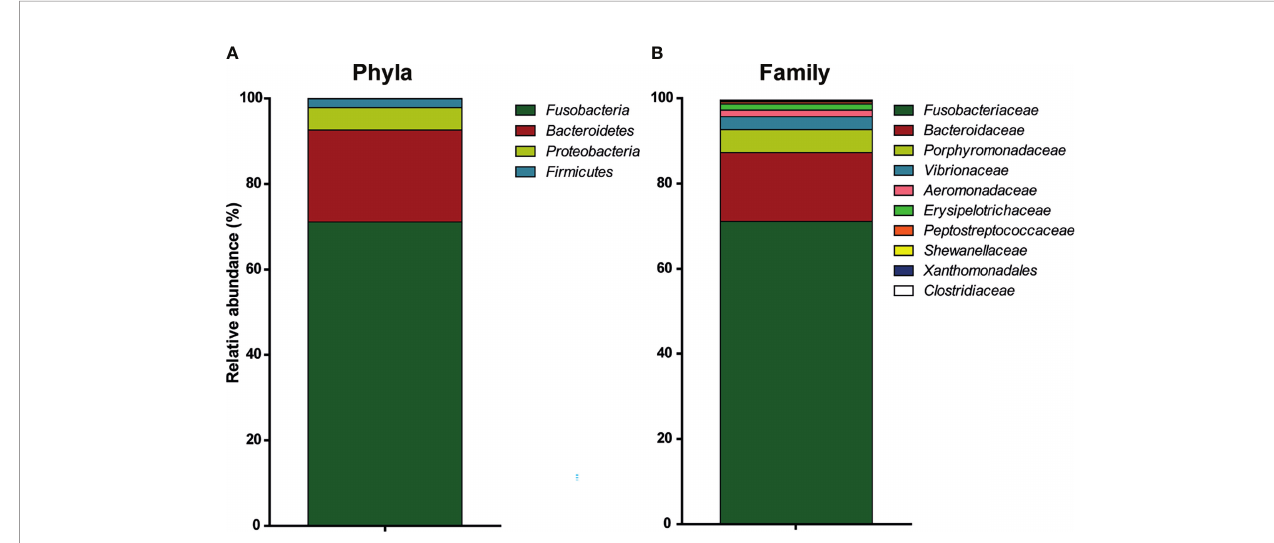
FIGURE 1 | Relative abundance of active bacteria in the intestinal microbiota of common carp. Characterization with 16S rRNA sequencing of the intestinal microbiota of naive, unhandled common carp [(bars indicate relative abundance (mean, n = 5)]. (A) Relative abundance of phyla. (B) Relative abundance of family. Xanthomonadales refers to family Xanthomonadales Incertae sedis